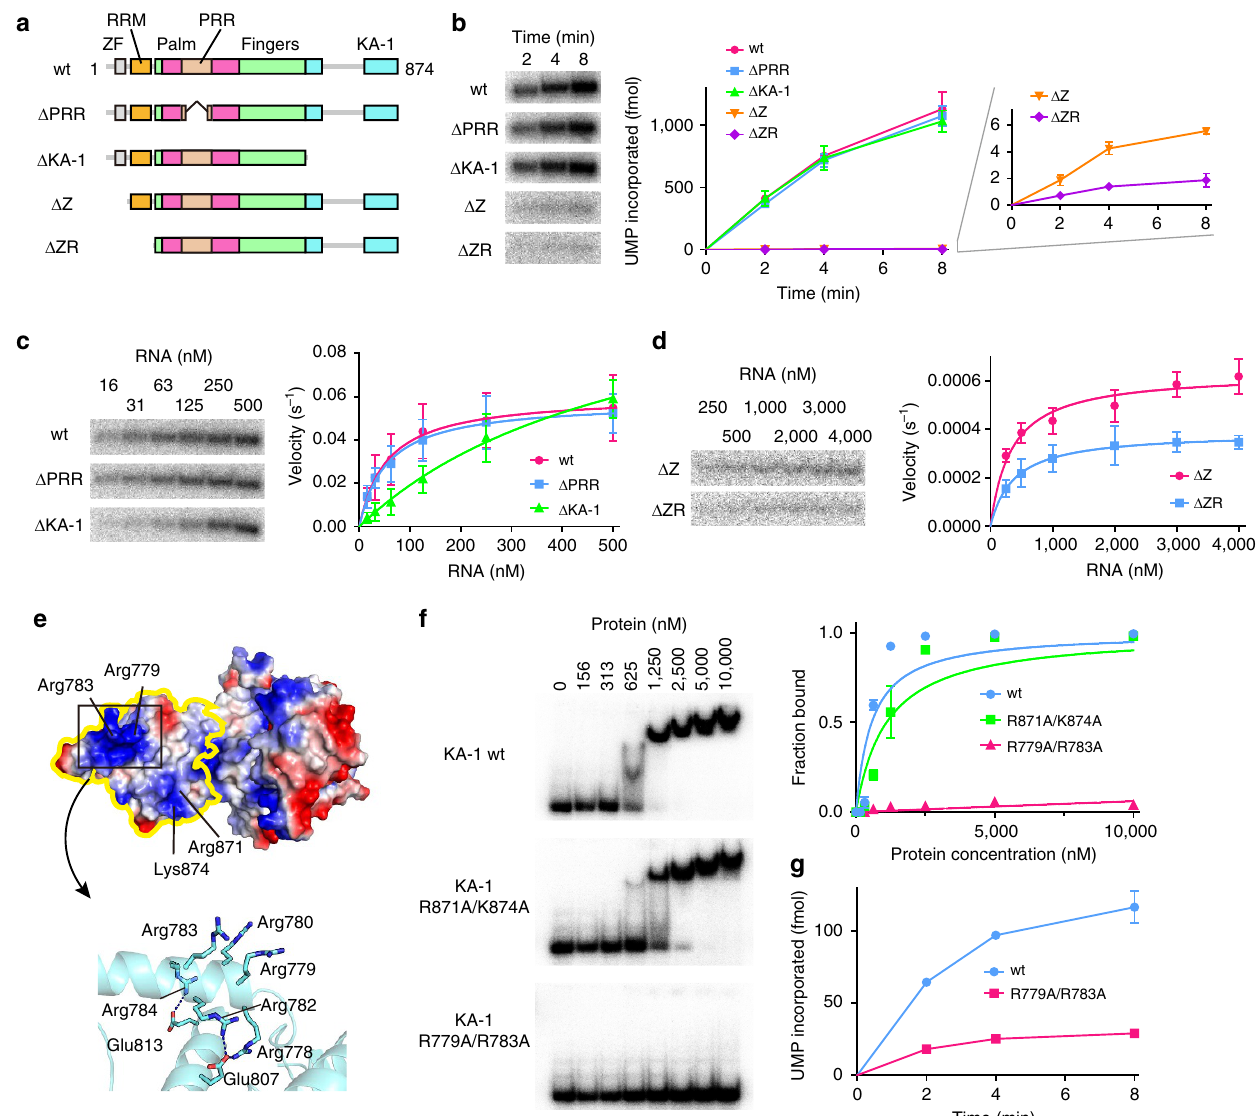
Figure 3 | Domain requirements for uridylylation by human TUT1. ( a ) Schematic diagrams of TUT1 variants used for biochemical assays. ( b ) Time-courses of UMP incorporation into U6 snRNA-u4 by wild-type TUT1 and its variants under the standard conditions (1 m M RNA and 10nM protein). Magnified view of UMP incorporation by D Z and D ZR (right) ( c ) Steady-state kinetics of UMP incorporation into U6 snRNA-u4 by wild-type TUT1, D PRR and D KA-1, with various RNA concentrations (0–500nM). ( d ) Steady-state kinetics of UMP incorporation into U6 snRNA-u4 by D Z and D ZR, with various RNA concentrations (0–4,000nM). ( e ) Electrostatic surface representation of TUT1_ D N. The positively and negatively charged areas are coloured blue and red, respectively. The KA-1 domain of TUT1 is framed by a yellow line. The positions of R797, R783, R871 and K874 are indicated (upper). A detailed view of the positively charged region in KA-1 (lower). ( f ) Gel retardation assays using various concentrations of wild-type and mutant KA-1 (R871A/K874A and R779A/R783A) proteins (0–10,000nM). ( g ) Time-courses of UMP incorporation into U6 snRNA-u4 by wild-type and R779A/R783A TUT1 (0.1 m M RNA and 5nM protein). Bars in the graphs ( b – d , f , g ) indicate s.d. of two or three independent